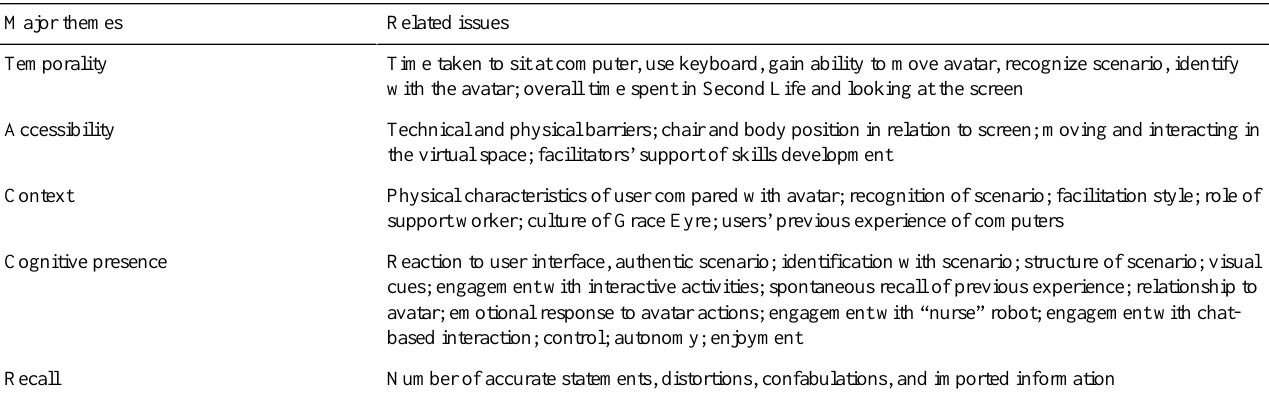
Related issuesMajor